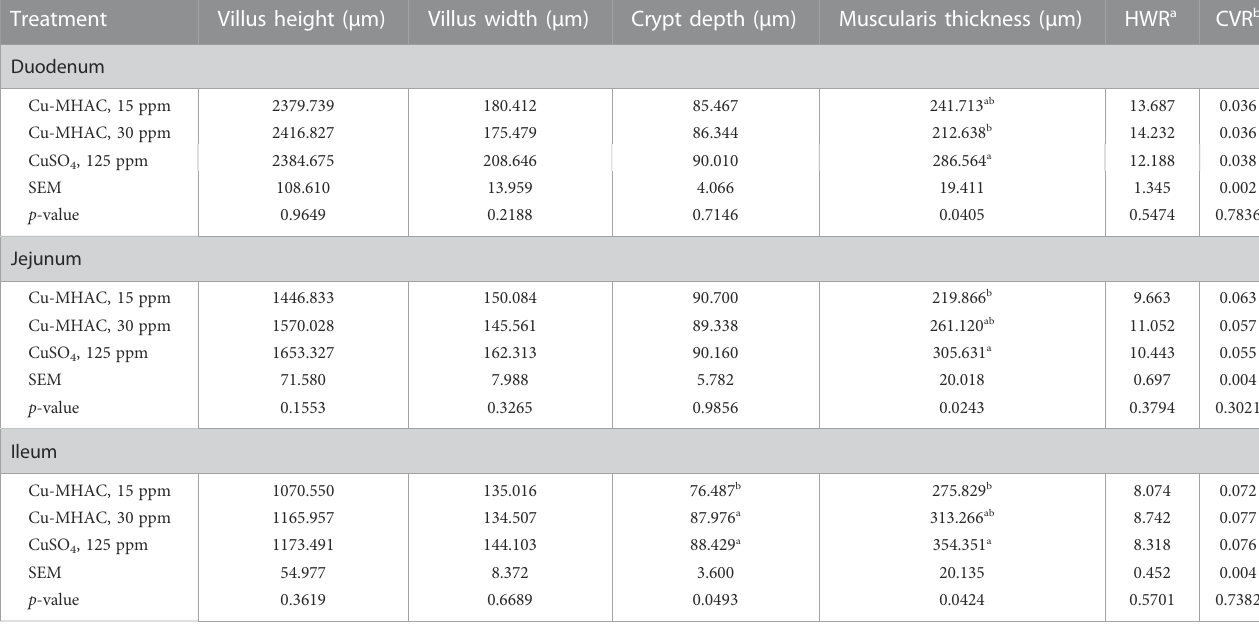
TABLE 10 Duodenal, jejunal and ileal morphometry of broilers at 43 days of age.